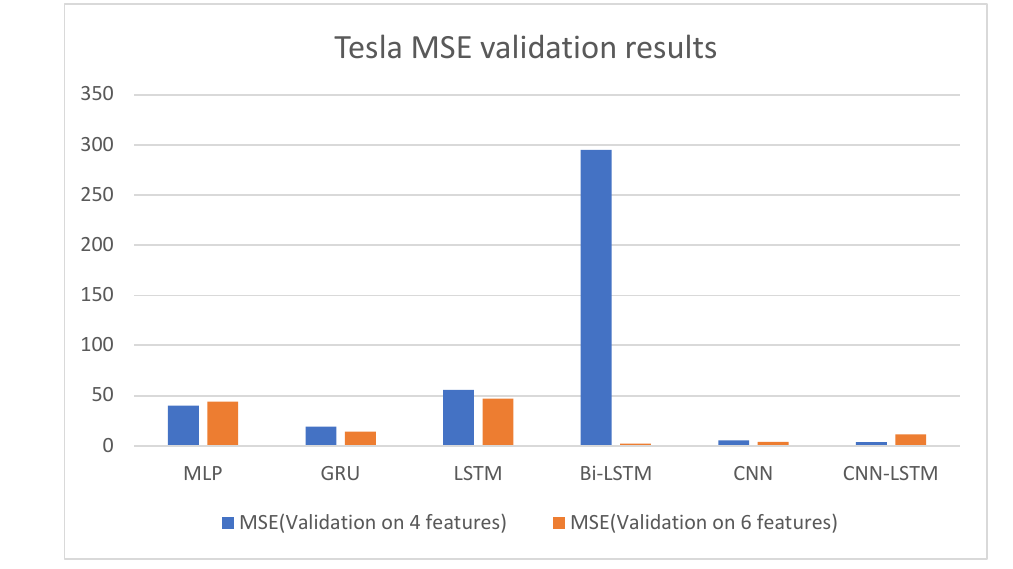
Figure 7. The visualization of the MSE results for Tesla .